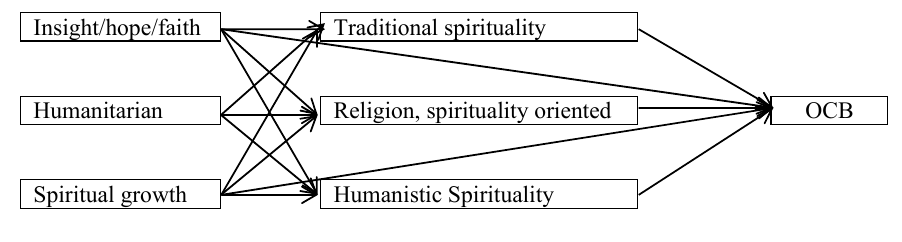
Fig. 1. The proposed